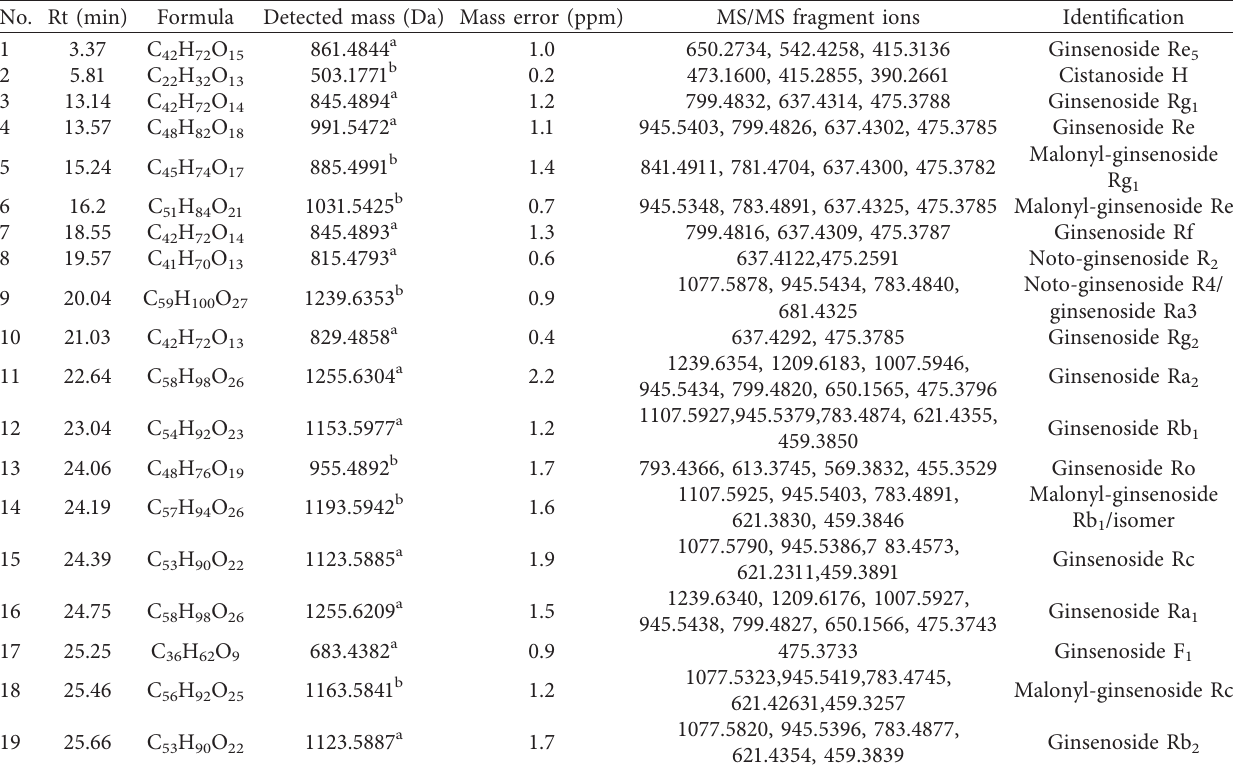
Figure 1: Total ion chromatogram (TIC) of extruded white ginseng (a) and white ginseng (b). Table 1: Compounds identified from white ginseng and extruded white